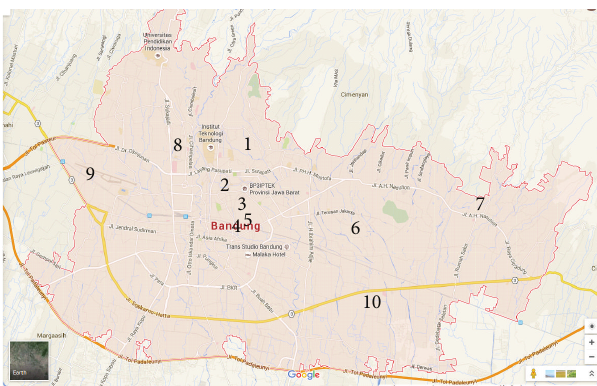
Figure 2: Map of Bandung from Google Maps. The numbers indicate the locations where the waste was collected: (1) Puter, (2) Ambon, (3) Patrakomala, (4) Kosambi, (5) Gudang Selatan, (6) Cibatu Antapani, (7) Cijambe, (8) Sederhana, (9) Ciroyom, and (10) Cijawura.